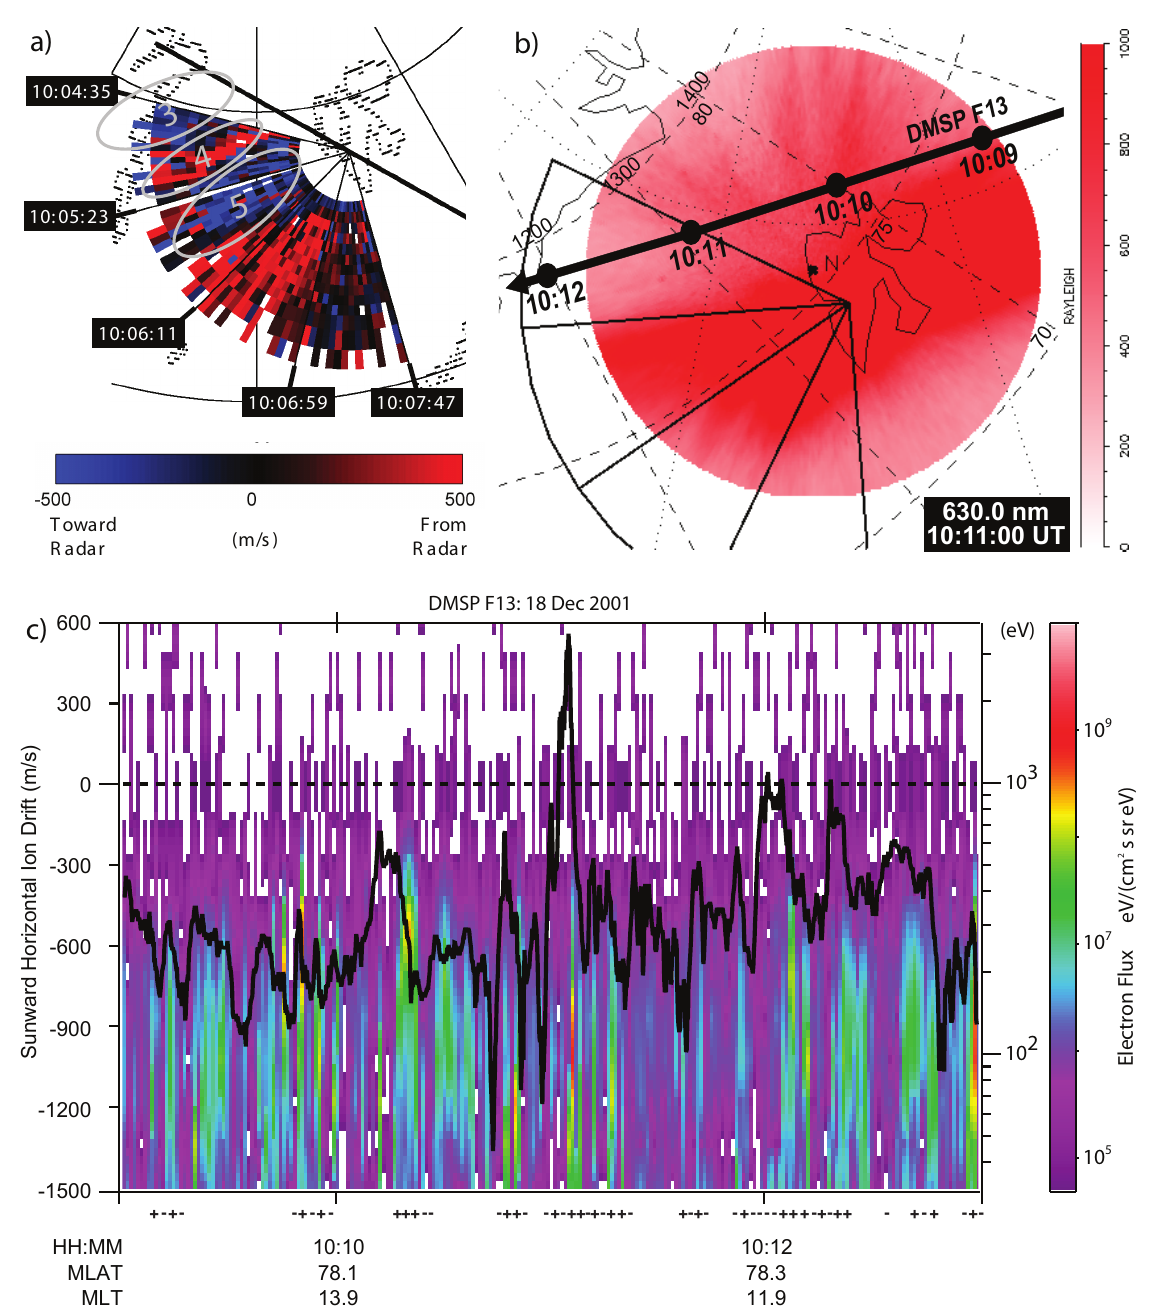
Fig. 8. Panel (a) shows a pair of > 1km/s velocity shears measured within the ESR field-of-view (full red is 500m/s away from the radar, full blue is 500m/s towards the radar, black is 0m/s). Panel (b) overlays a coincident 630.0nm ASIP image on the same area, includes the coincident DMSP F13 satellite track as a thick black line, and shows the ESR field-of-view with thin black lines. The left scale in panel (c) shows the coincident DMSP F13 driftmeter data, and the right scale in panel (c) shows a color spectrogram of the coincident electron particle fluxes ∼ 10 6 –10 9 eV/(cm 2 ssreV). Near 10:11UT the driftmeter shows a greater than km/s plasma flow shear ( > 500m/s sunward to > 500m/s anti-sunward). The sunward plasma flow measured near 10:11UT by DMSP is the same feature measured by the ESR at 10:05UT. Its optical signature was tracked poleward for over 10min for hundreds of km by the ASIP. These data are distilled from Oksavik et al. (2005). Below panel (c), examples of convergence and divergence regions are indicated “+” and “ − ”,